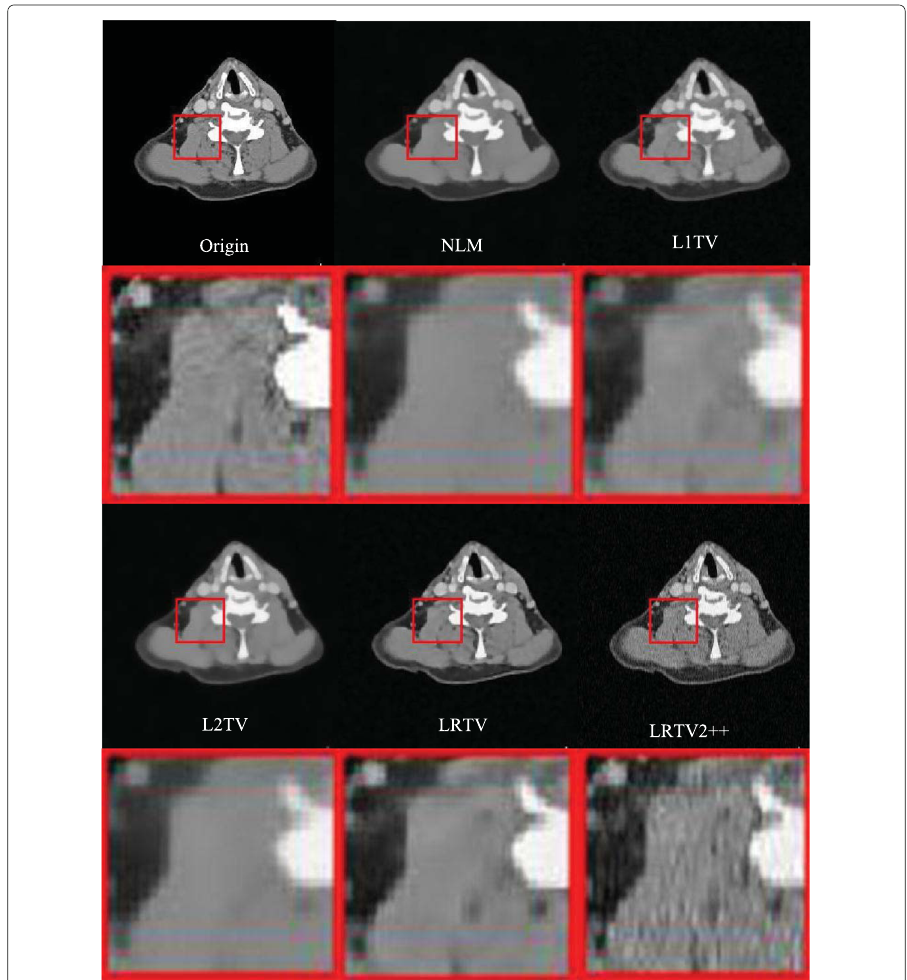
Fig. 3 The performance of recovered images of different methods and enlarged regions (4-HEADNECK 2.0